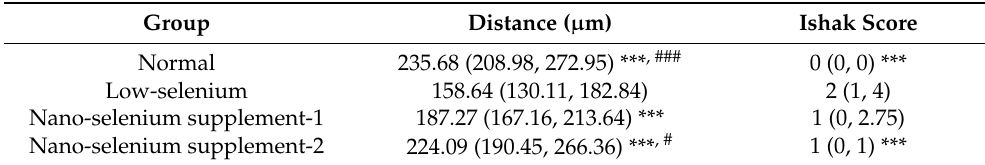
Table 1. Distance between the portal and central venous regions of the liver and Ishak score to determine liver fibrosis severity. Group Distance ( µ m) Ishak Score Normal 235.68 (208.98, 272.95) *** , ### 0 (0, 0) *** Low-selenium 158.64 (130.11, 182.84) 2 (1, 4) Nano-selenium supplement-1 187.27 (167.16, 213.64) *** 1 (0, 2.75) Nano-selenium supplement-2 224.09 (190.45, 266.36) *** , # 1 (0, 1)